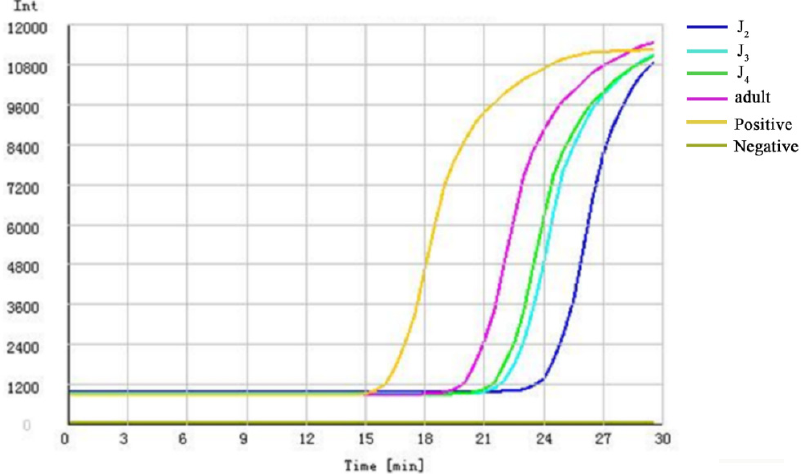
Figure 8. The amplification curve of DNA of individual nematodes at different stages of development resulting from EMA.